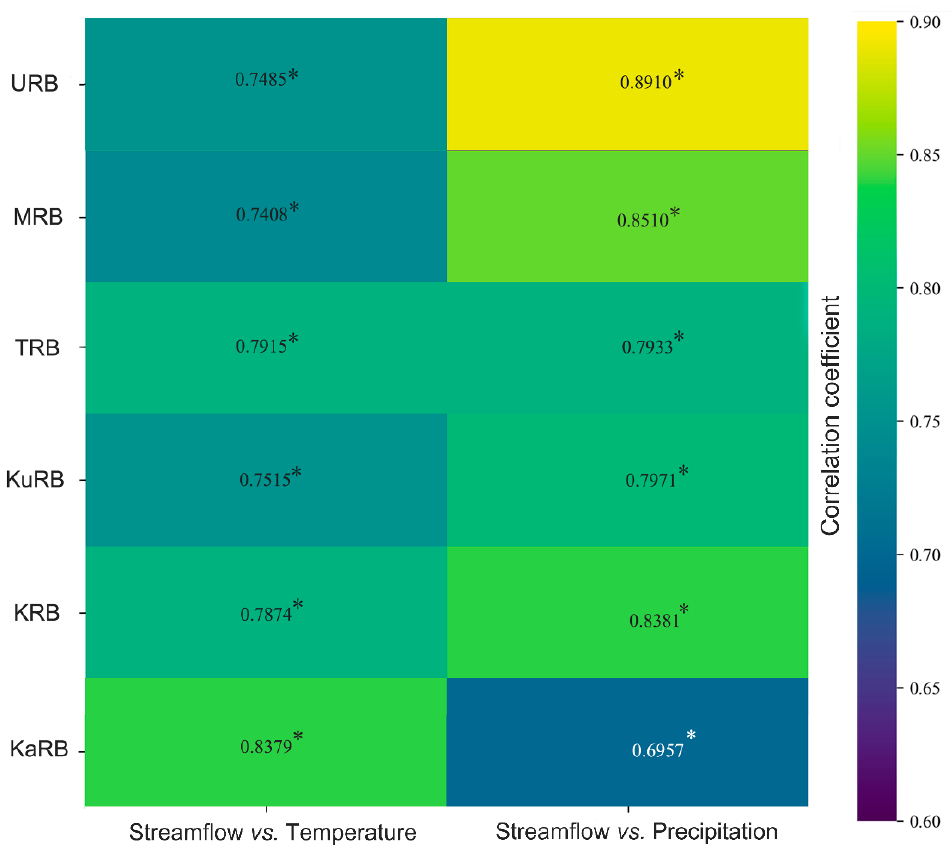
Figure 3. Correlation coefficients between climate and runoff on a monthly scale. * indicates the significance of a < 0.01.